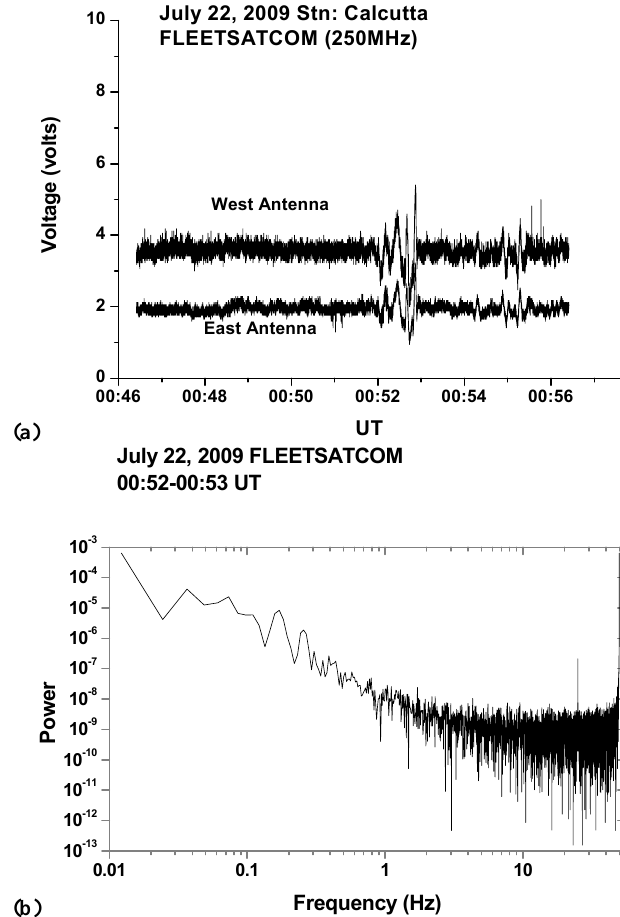
Fig. 9. The patch of amplitude scintillation observed on the VHF link from Calcutta on two antennas is shown in (a) while (b) shows the corresponding power spectrum during 00:52–00:53UT. Kharagpur. However the periods found were different from earlier reported values possibly due to shorter distances of the stations presently used from the umbra region. During the annular eclipse on 15 January 2010, the diurnal maxi- mum value of TEC around 08:30 UT was noticeably lower in comparison to the preceding and the following day. Peri- odic structures have been identified on this occasion too on some GPS links. However a more detailed analysis along these lines will be necessary for improved understanding